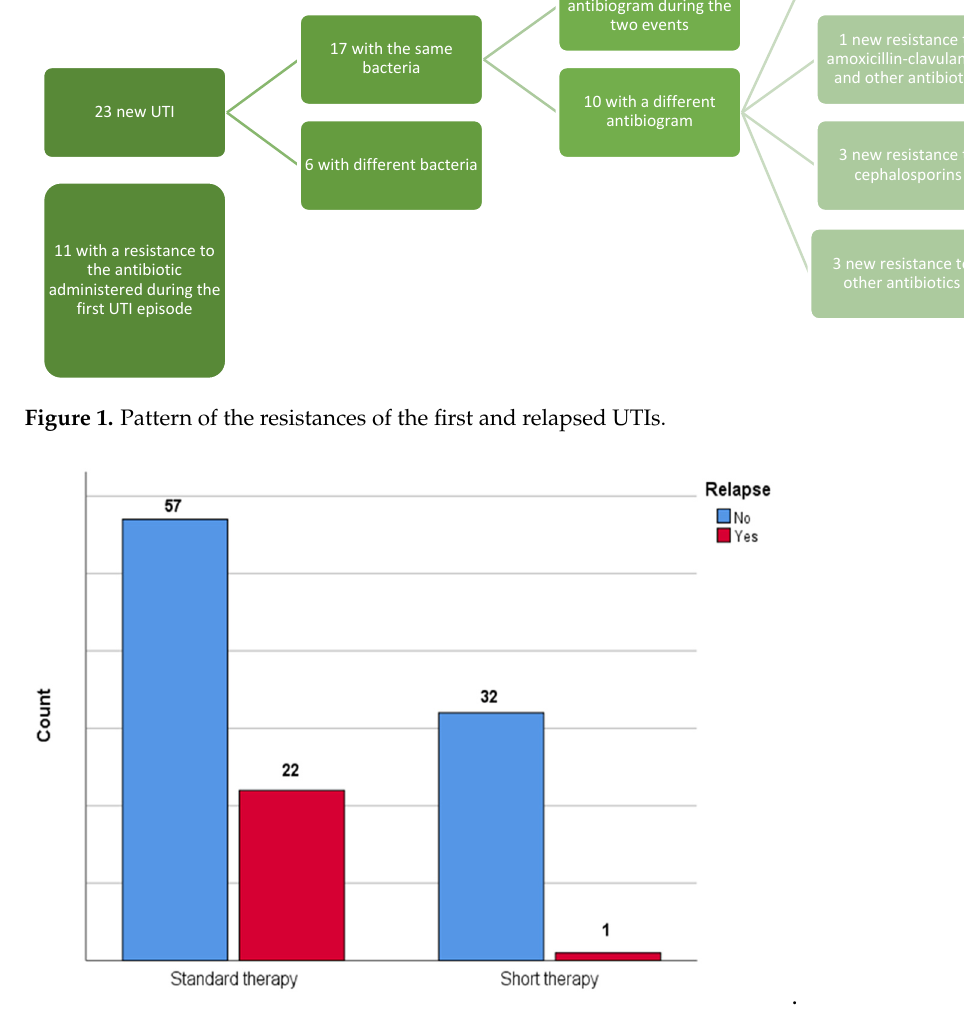
Figure 2. The figure shows the comparison between patients who underwent short therapy and patients who underwent standard therapy in the number of urinary tract relapses in our cohort. A comparison between the characteristics of patients with relapse and patients with- out relapse is reported in Table 2. The only statistically significant association observed was with the neutrophil count. Table 2. Clinical information and demographics of the population divided according to the presence of a relapse of urinary tract infection.